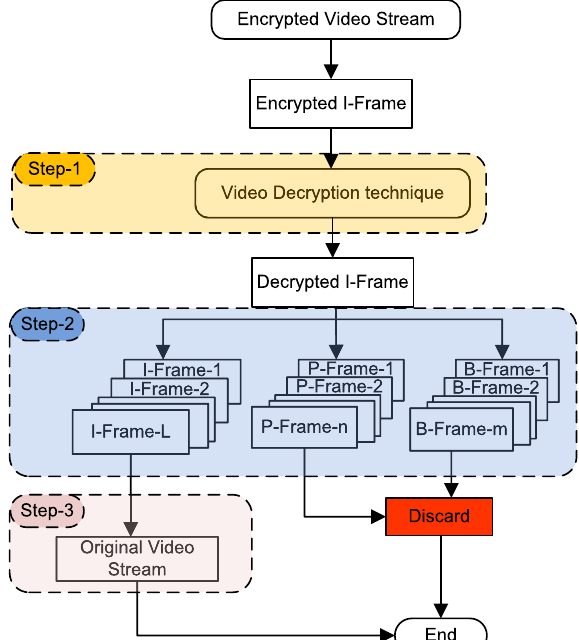
Fig. 4 f ramework of video decryption